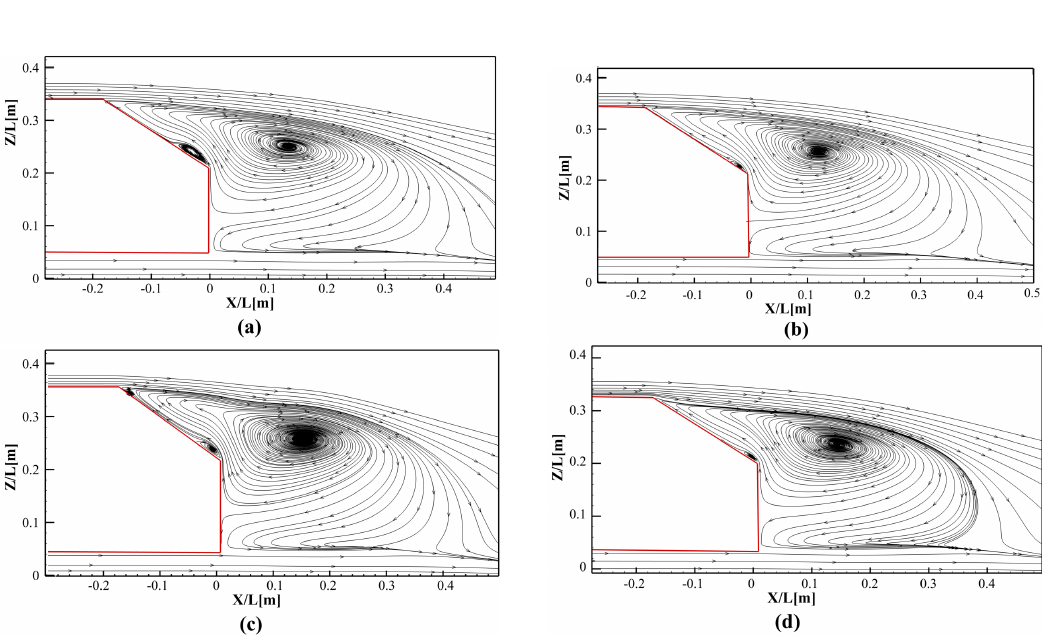
Figure 12. Streamlines on the symmetry plane for slant angle 35 ◦ and Re = 2.25 × 10 5 . ( a ) Actuator off, ( b ) case 1, ( c ) case 2, ( d ) case